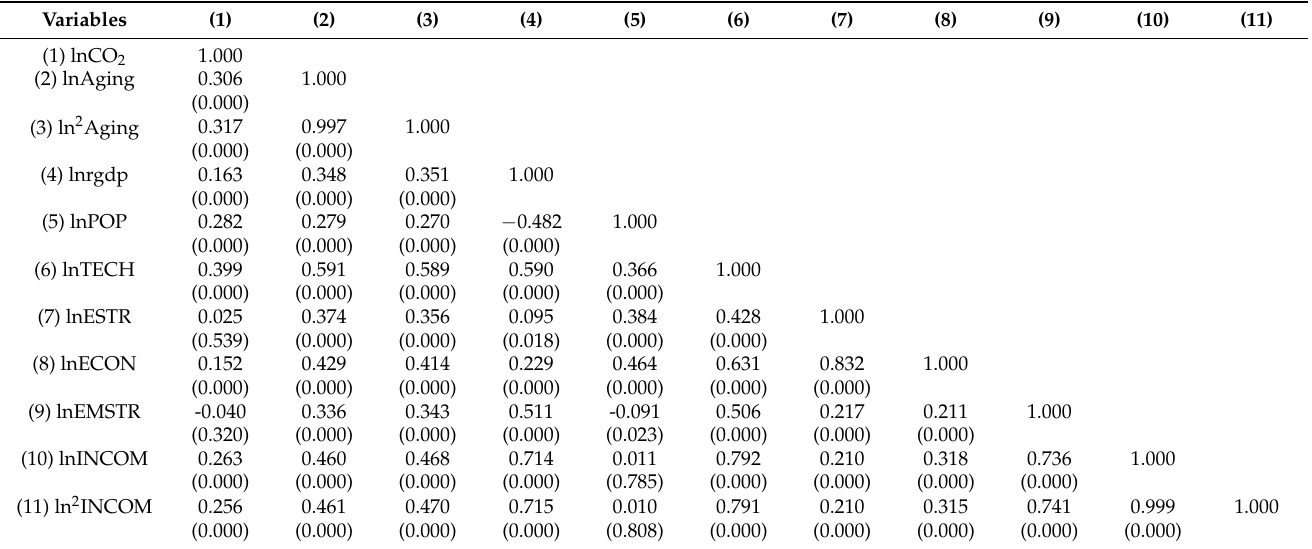
Table 3. Correlation analysis of